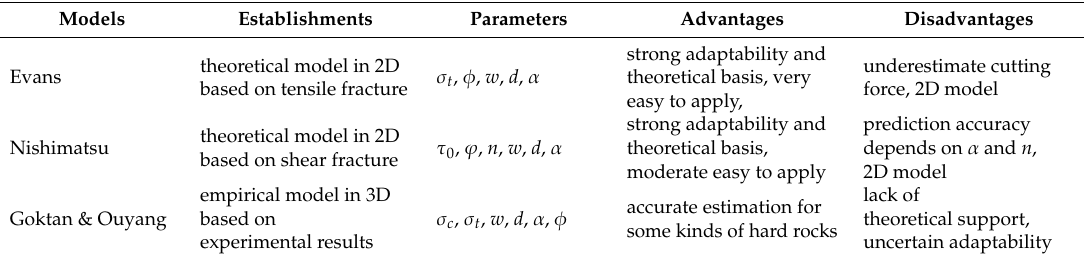
Table 1. Comparison of existing models for rock cutting with chisel picks.